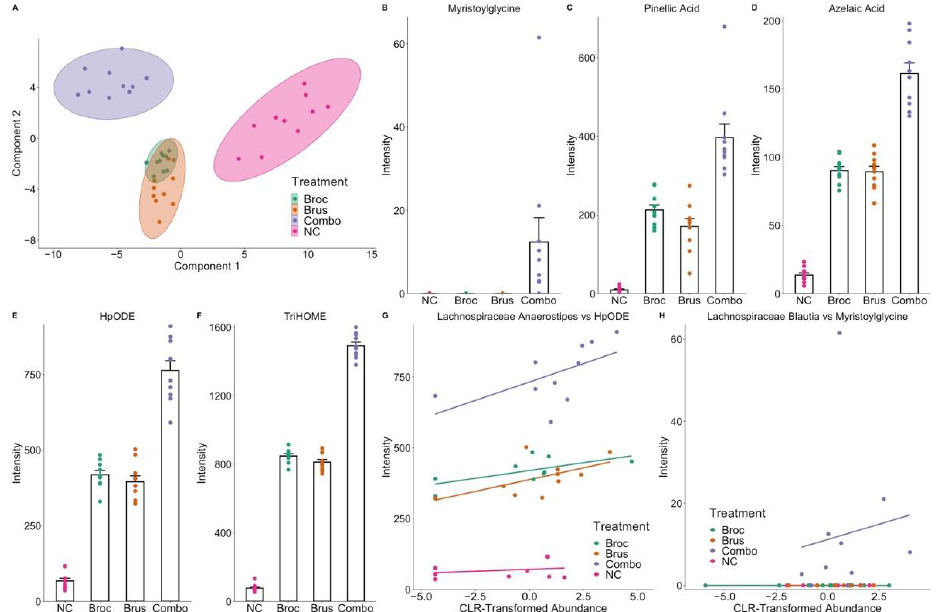
Figure 4. Multi-block PLS-DA reveals signatures of cruciferous vegetable exposure and relationships between specific microbes and metabolites. ( A ) Consensus plot from multi-block PLS-DA analysis. Each point represents one fecal culture, and the color of each point represents the treatment group. ( B – F ) Intensity of select metabolites identified by multi-block PLS-DA. Each point represents an individual, bars represent means, and error bars show standard error. ( G , H ) Plots comparing intensity of metabolites with the centered log-ratio transformed abundance of select microbes. Each point represents a fecal culture, and lines show within-treatment group correlation. For both presented metabolites, different within-treatment correlations are observed, suggesting that the metabolism of these compounds by the gut microbiome is dependent on the presence of precursor compounds that come from the vegetables themselves.